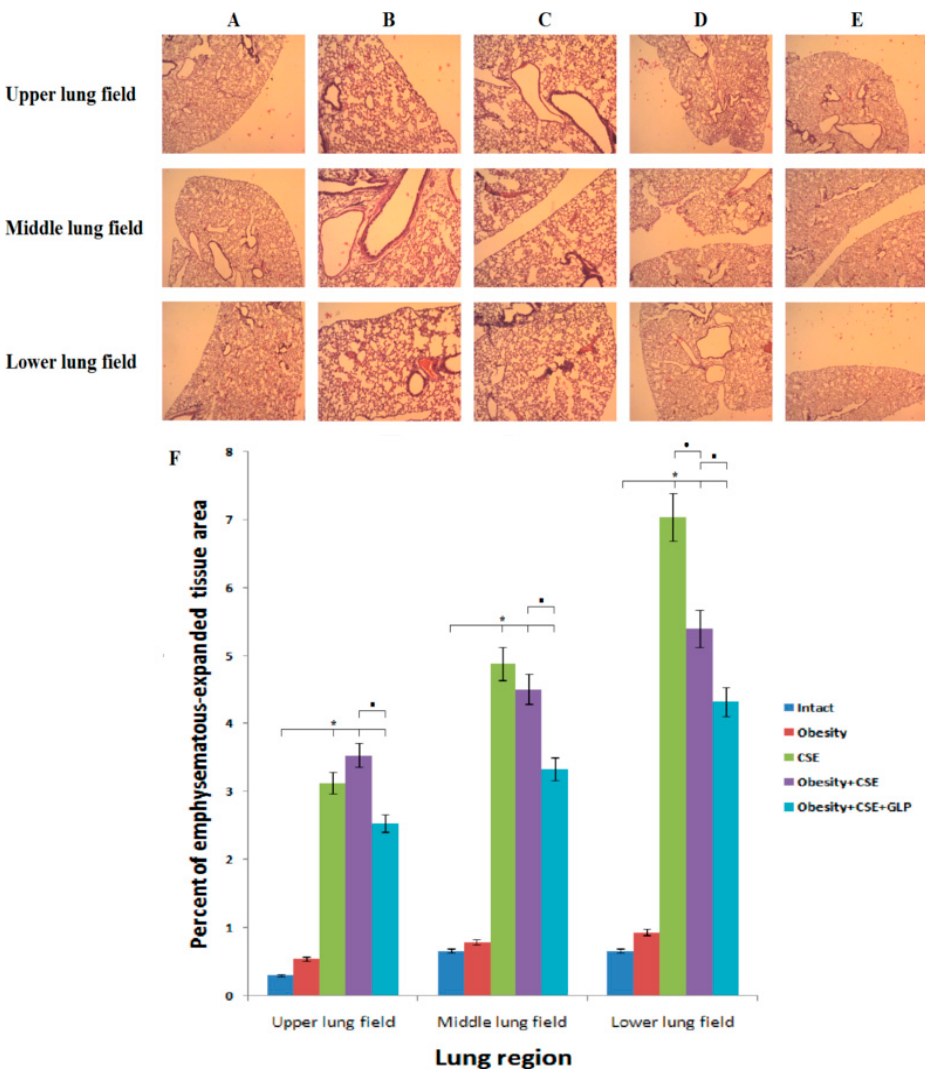
Figure 3. Photomicrographs of left lung sections (upper, middle and lower pulmonary field) obtained from female C57BL/6 mice ( n = 6). Tissues were stained with hematoxylin-eosin (188th day of the experiment). ( A ) Control group; ( B ) Obesity; ( C ) CSE; ( D ) Obesity + CSE; ( E ) Obesity + CSE + GLP-1; ( F ) The area of emphysema-expanded lung tissue of mice from all groups. * p < 0.05 significance of difference compared with control group, ■ p < 0.05 significance of difference compared with the obesity + CSE group.